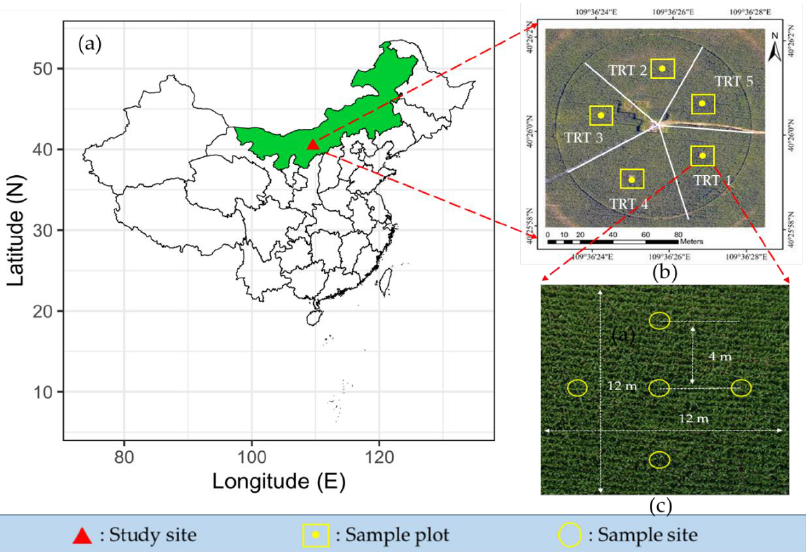
Figure 1. Location and treatment division of research field: ( a ) location of research field in China; ( b ) treatment zones and locations of sampling plots, and ( c ) sampling sites in a plot. Each treatment zone had one sample plot and each sample plot had five sample sites.